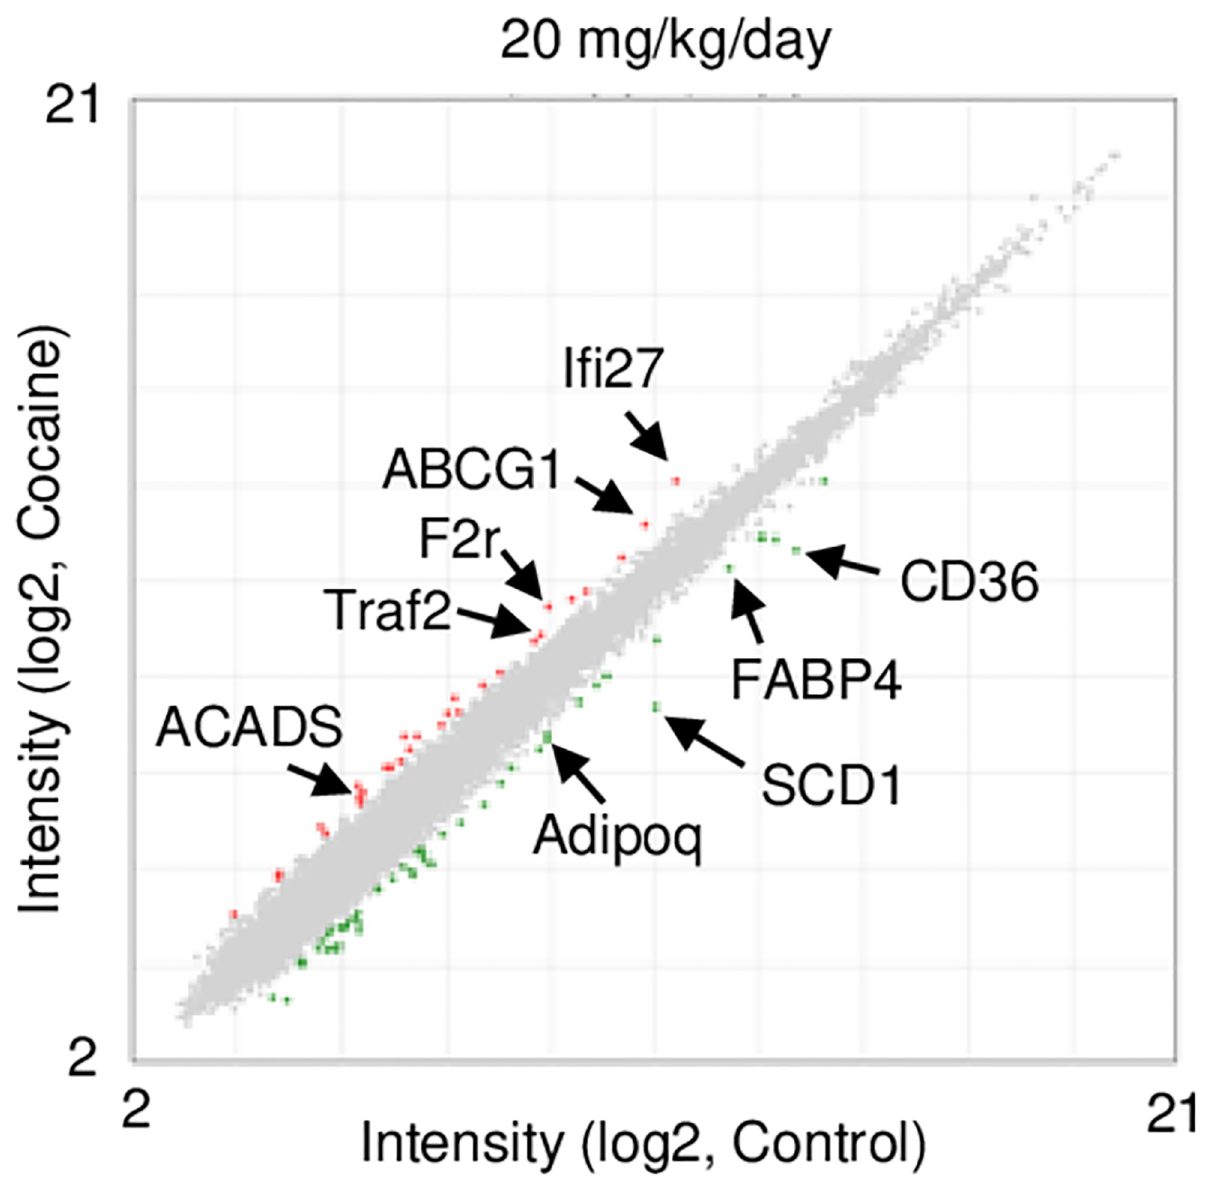
Fig 2. Transcriptome analysis of the thymus in rats administered cocaine. Rats were treated with or without cocaine (20 mg/kg/day, 7 days). Total RNA was extracted from the thymus and subjected to DNA microarray analysis. The scatter plot shows transcripts upregulated (red circles) and downregulated (green circles) by more than 2-fold by cocaine treatment. (Fig 2), Ifi27/Isg12a (interferon alpha inducible protein 27/interferon-stimulated genes 12a) and Traf2 (TNF receptor-associated factor 2) have been shown to be involved in apoptosis [18, 19]. Increased expressions of several genes involved in lipid metabolism were also found (Fig 2); Acads (acyl-CoA dehydrogenase short chain) is involved in the β -oxidation of fatty acids in mitochondria [20] while Abcg1 (ATP-binding cassette subfamily G member 1) mediates cho- lesterol efflux from cells [21]. On the other hand, decreased expressions of genes involved in FA transport into cells, Cd36 and Fabp4 (fatty acid binding protein 4) [15], were observed in